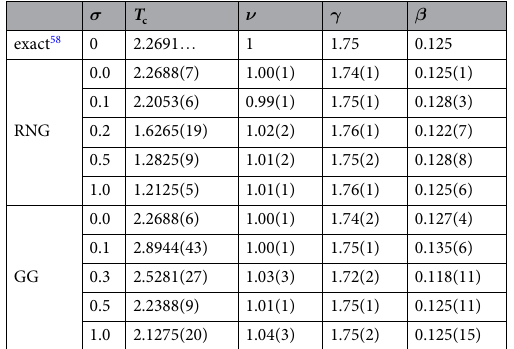
Table 1. Critical exponents for different values of σ . A finite size scaling analysis was performed to determine the critical exponents β , γ , ν and the critical temperature T c . The errors for β and γ are estimated with the method from by an iterative method 52 . The errors of ν and T c are the standard deviation of three obtained values through different collapses. The critical exponents are in reasonable agreement with the exact known values for the 2D Ising universality class. The critical temperatures T c are shifting as